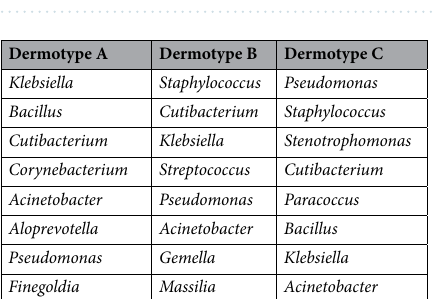
Figure 4. The relative abundance of the most predominant genera in cutaneous microbiomes of healthy and patients with RID groups. ( a ) Bar plots depict the mean proportion and differences in mean proportions with 95% confidence intervals. ( b ) The core genera of the entire dataset are indicated by green boxes. ( c ) Colored boxes indicate the core microbiome of healthy and patients with RID, and strikes represent the statistically different genera between study groups. Statistical significance of pairwise comparisons was defined using the nonparametric Wilcoxon rank-sum test. Significant differences were displayed with either ns, p-value > 1; *p < 0.05, **p < 0.01 or ***p < 0.001. ( d ) Potential biomarkers for each group were inferred using LEfSe and the numbers denote LDA scores.